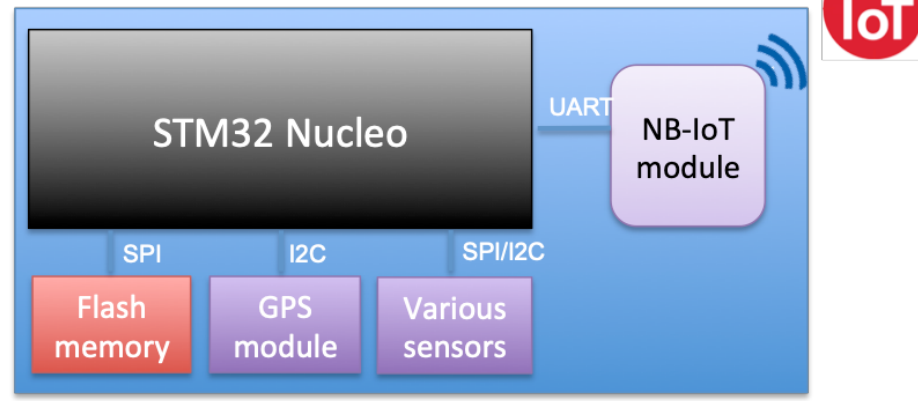
Figure 3. Device Setup prototype.